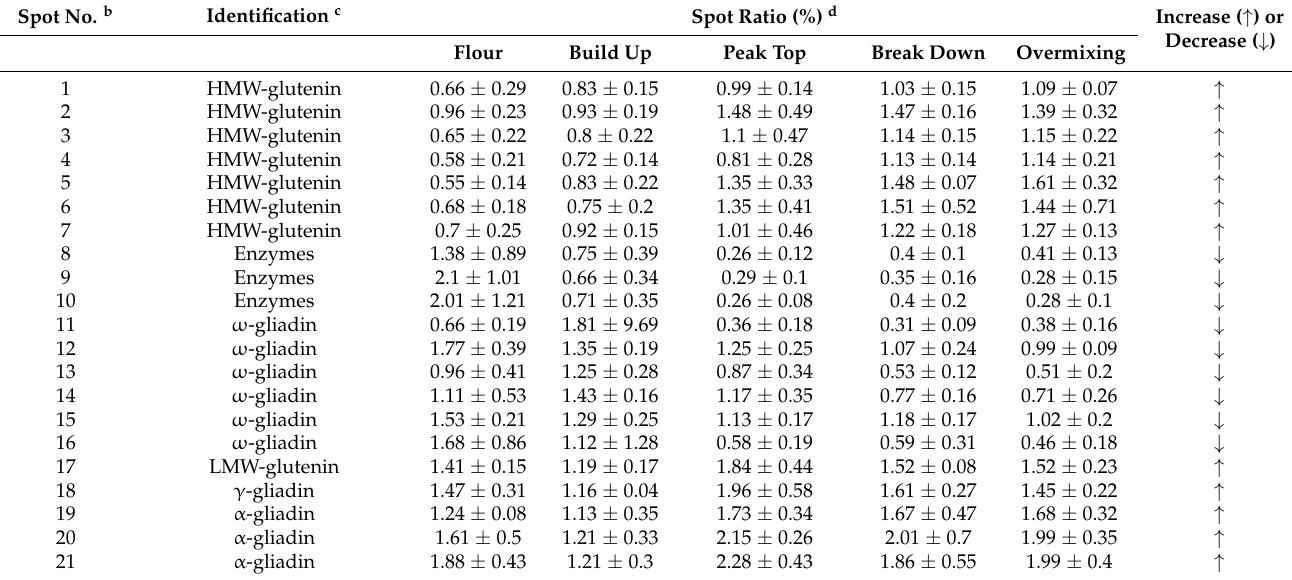
Table 1. The increased or decreased protein in protein aggregates extracted with 30% 1-propanol in HF a during mixing. Spot No. b